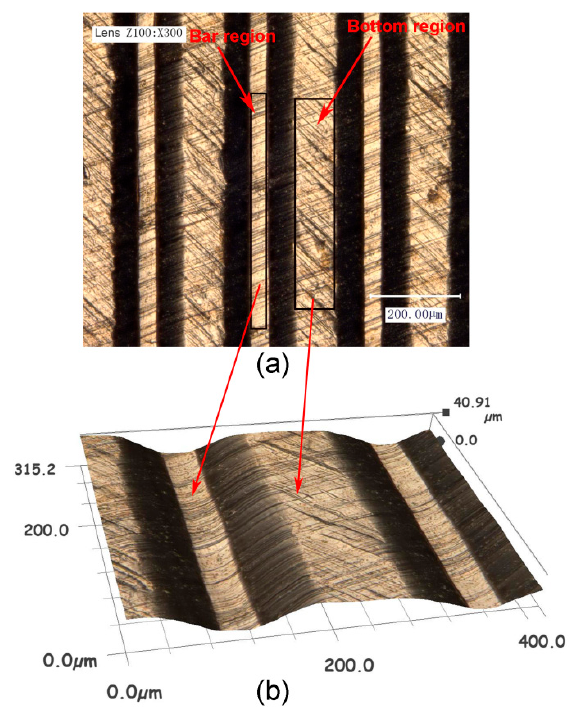
Figure 22. ( a ) 2 ‐ D surface roughness measurement positions and ( b ) local magnified morphology of roughness measurement positions in 3 ‐ D. Metals 2018 , 8 , x FOR PEER REVIEW 25 of 33